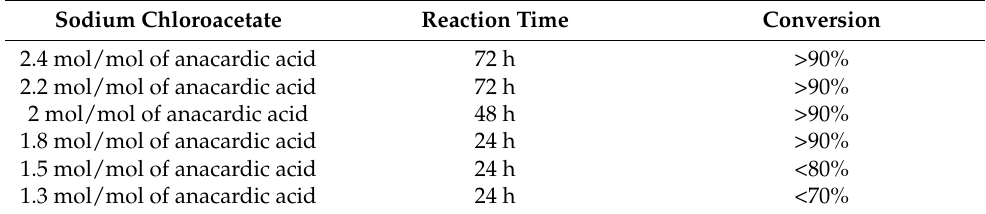
Table 6. Stoichiometry of sodium chloroacetate relative of anacardic acid for oxyacetic acid and reaction time of anacardic acid ( 5 )